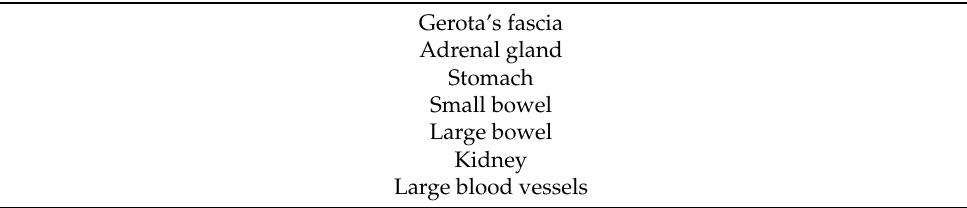
Table 1. Additional structures that may be resected during extended distal pancreatectomy procedures.